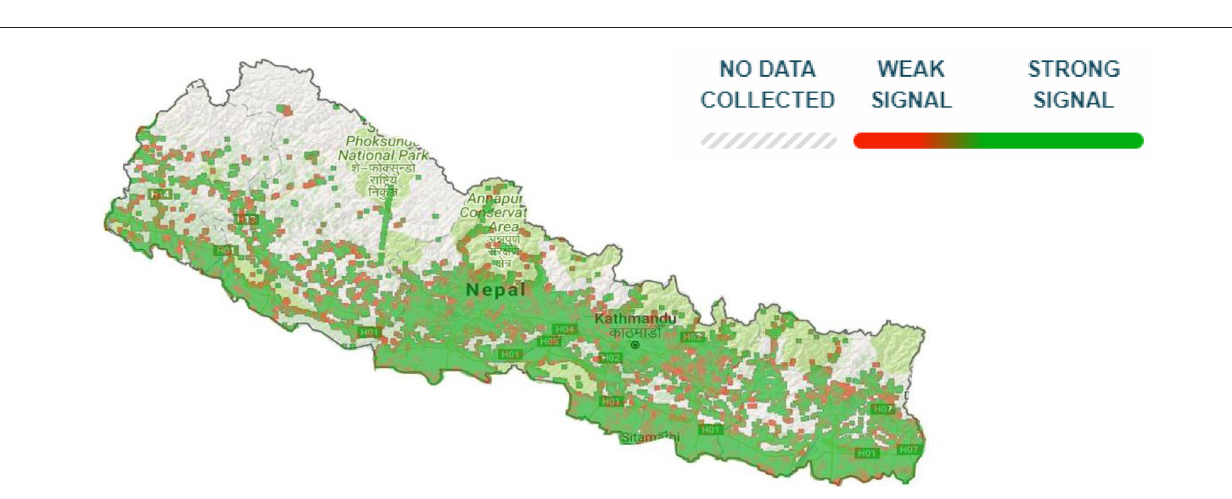
FIGURE 3 | Opensignal 2G/3G/4G coverage map of Nepal